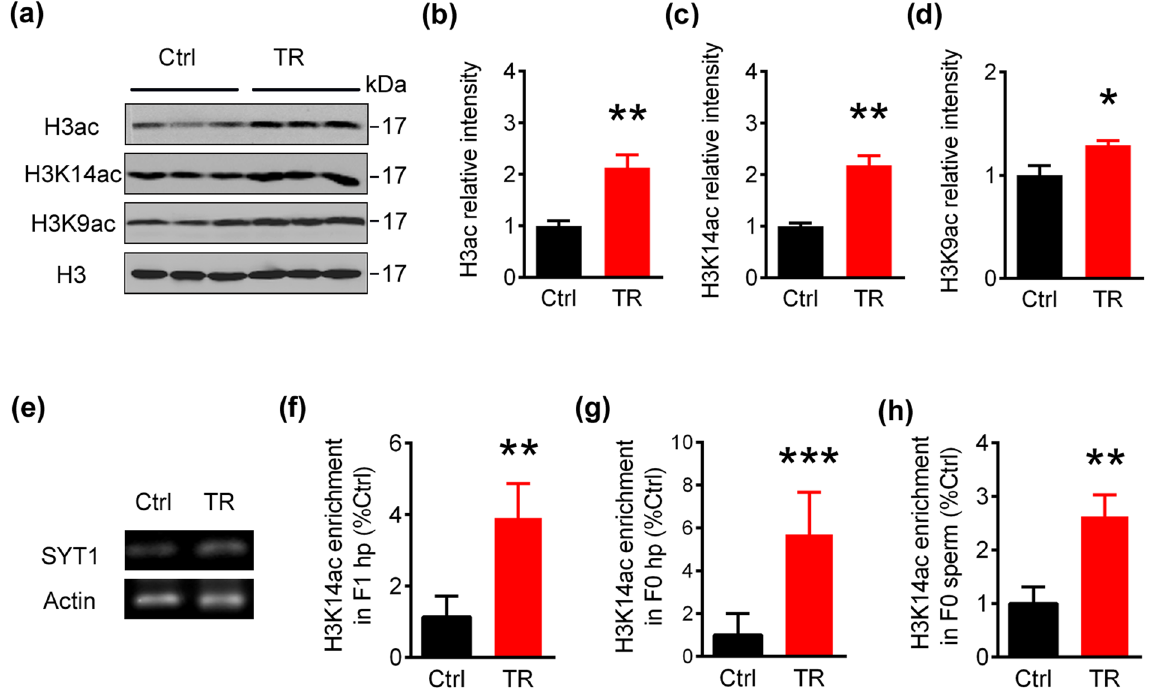
Figure 3. Paternal spatial training induces transgenerational augmentation of histone acetylation at SYT1 promoter regions in 129s F1 offspring. ( a–d ) Acetylated H3 (H3ac), acetylated H3K14 (H3K14ac) and acetylated H3K9 (H3K9ac) level in hippocampus of 7-m 129s F1 offspring normalized by histone 3 (H3) measured by Western blotting. The blot images were cropped to display and quantitifed by the Odyssey Infrared Imaging System (Licor biosciences, Lincoln, NE, USA). Bar graphs show mean ± SEM ( * p < 0.05, ** p < 0.01, two-tail t-test, H3ac: n = 6 per group; H3K14ac and H3K9ac: n = 3 per group). ( e,f ) Level of the acetylated H3K14 associated with SYT1 promoter in 7-m old F1 offspring’s hippocampal extracts measured by chromatin immunoprecipitation assay (ChIP). β -actin was probed as loading control. Bar graphs show mean ± SEM ( ** p < 0.01, two-tail t-test, n = 6 per group). ( g ) Level of the acetylated H3K14 associated with SYT1 promoter in 3-m fathers’ hippocampal extracts measured by ChIP, normalized against β -actin. Bar graphs show mean ± SEM ( *** p < 0.001, two-tail t-test, Ctrl group: n = 8, TR group: n = 6). ( h ) Level of the acetylated H3K14 associated with SYT1 promoter in 3-m fathers’ sperm extracts measured by ChIP, normalized against β -actin. Bar graphs show mean ± SEM ( ** p < 0.01, two-tail t-test, n = 6 per